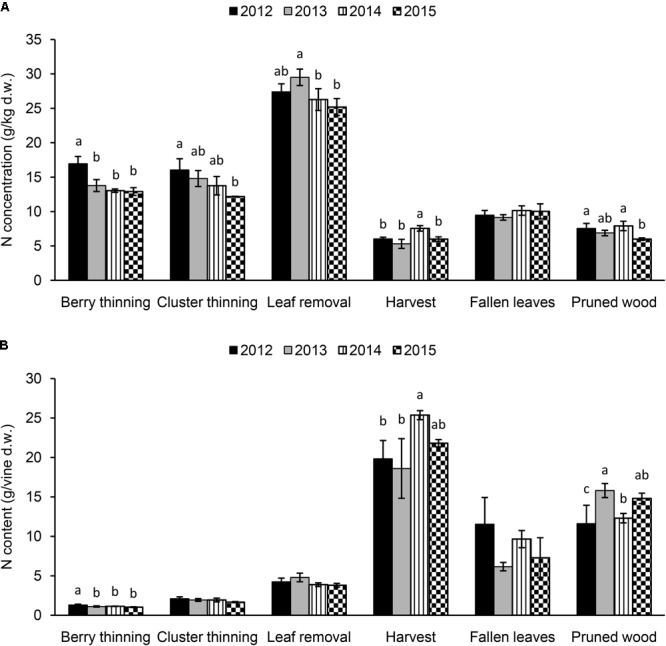
Nitrogen concentration (A) (g/kg of dry weight) and content (g per vine) (B) in the summer and winter pruned materials (berry thinning, cluster thinning, leaf removal, and pruned wood), fallen leaves at the end of season and harvested clusters of Italia table grape throughout the seasons of 2012, 2013, 2014, and 2015. Bars represent standard deviation. For each viticultural practice, data points followed by a different letter are significantly different at P ≤ 0.05 according to REGQW test.